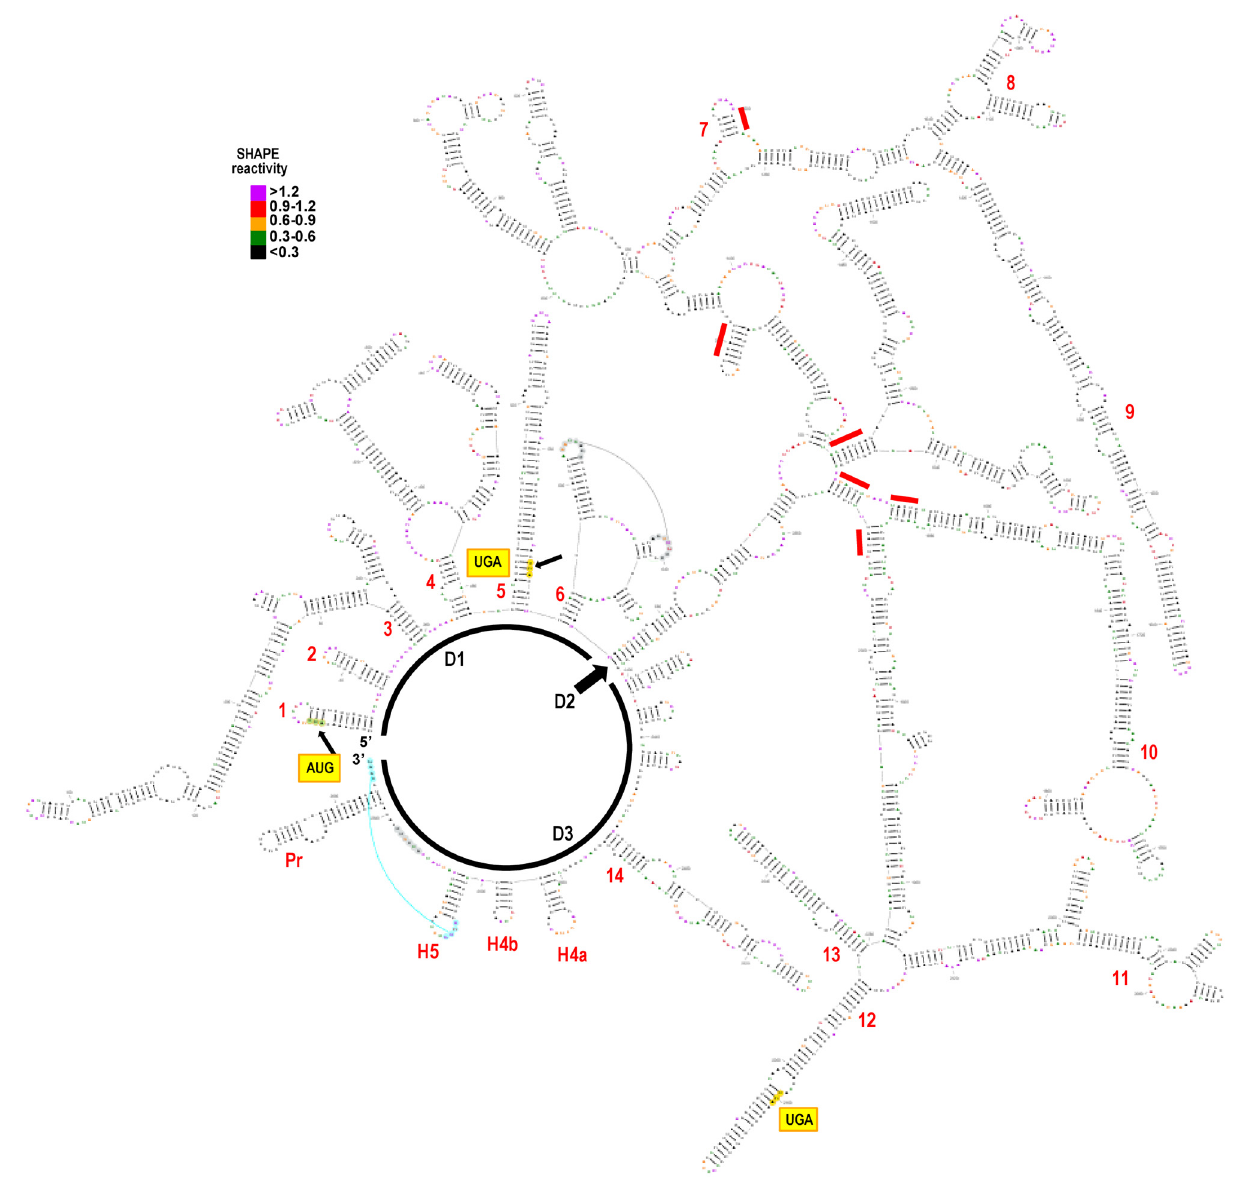
Figure 3. Proposed RNA structure for full-length CYVaV. CYVaV transcripts were synthesized using T7 RNA polymerase, denatured, snap cooled and then treated with NMIA or DMSO as described in the Materials and Methods. Ten primers labeled with 6FAM were used for reverse transcription of the SHAPE modified samples and PET was used for sequencing ladder samples. Data that was obtained from 2 to 3 repeats of the primer sets were analyzed using QuSHAPE software [28]. Colors denote SHAPE reactivity, with purple the most reactive, followed by red, orange, green and black being the least reactive. The structure was divided into three domains (D1, D2 and D3) for ease of presentation. Structures referred to in the text are numbered in red. Red lines denote key base-paired helices that were highly conserved in both sequence and structure among the Class 2 ulaRNAs, and that were important in conceptualizing the final structure. The location of the initiation codon for p21, p21 termination codon (UGA) and p81 termination codon UGA are shown. Two putative tertiary interactions (see text) are denoted by curved lines. Note that subsequent figures show enlargement of key regions of the structure and SHAPE data.